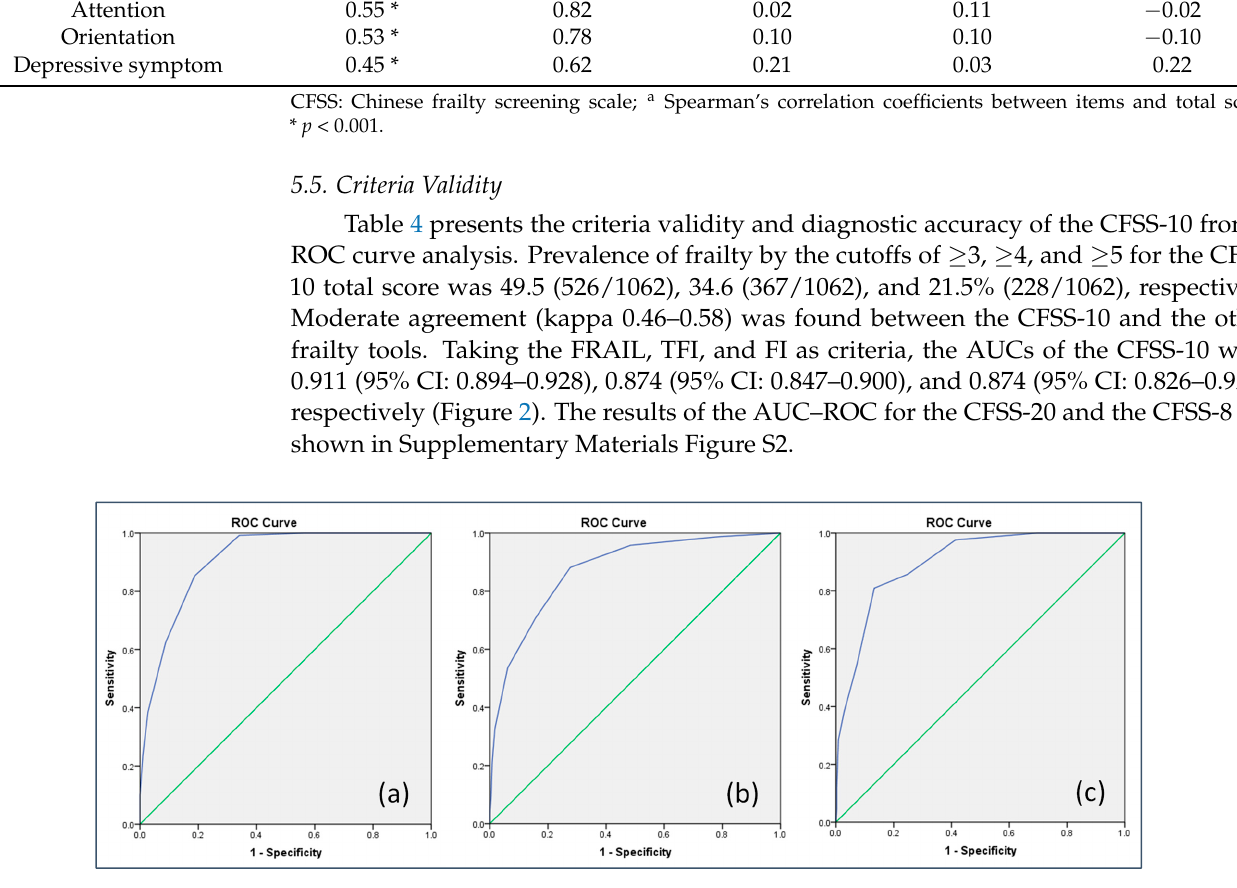
Figure 2. The AUCs of the CFSS-10 taking the FRAIL, TFI and FI as criteria (sample 1). ( a ). AUC of the CFSS-10 = 0.911 (95% CI: 0.894–0.928) taking the FRAIL as a criterion; ( b ). AUC of the CFSS-10 =